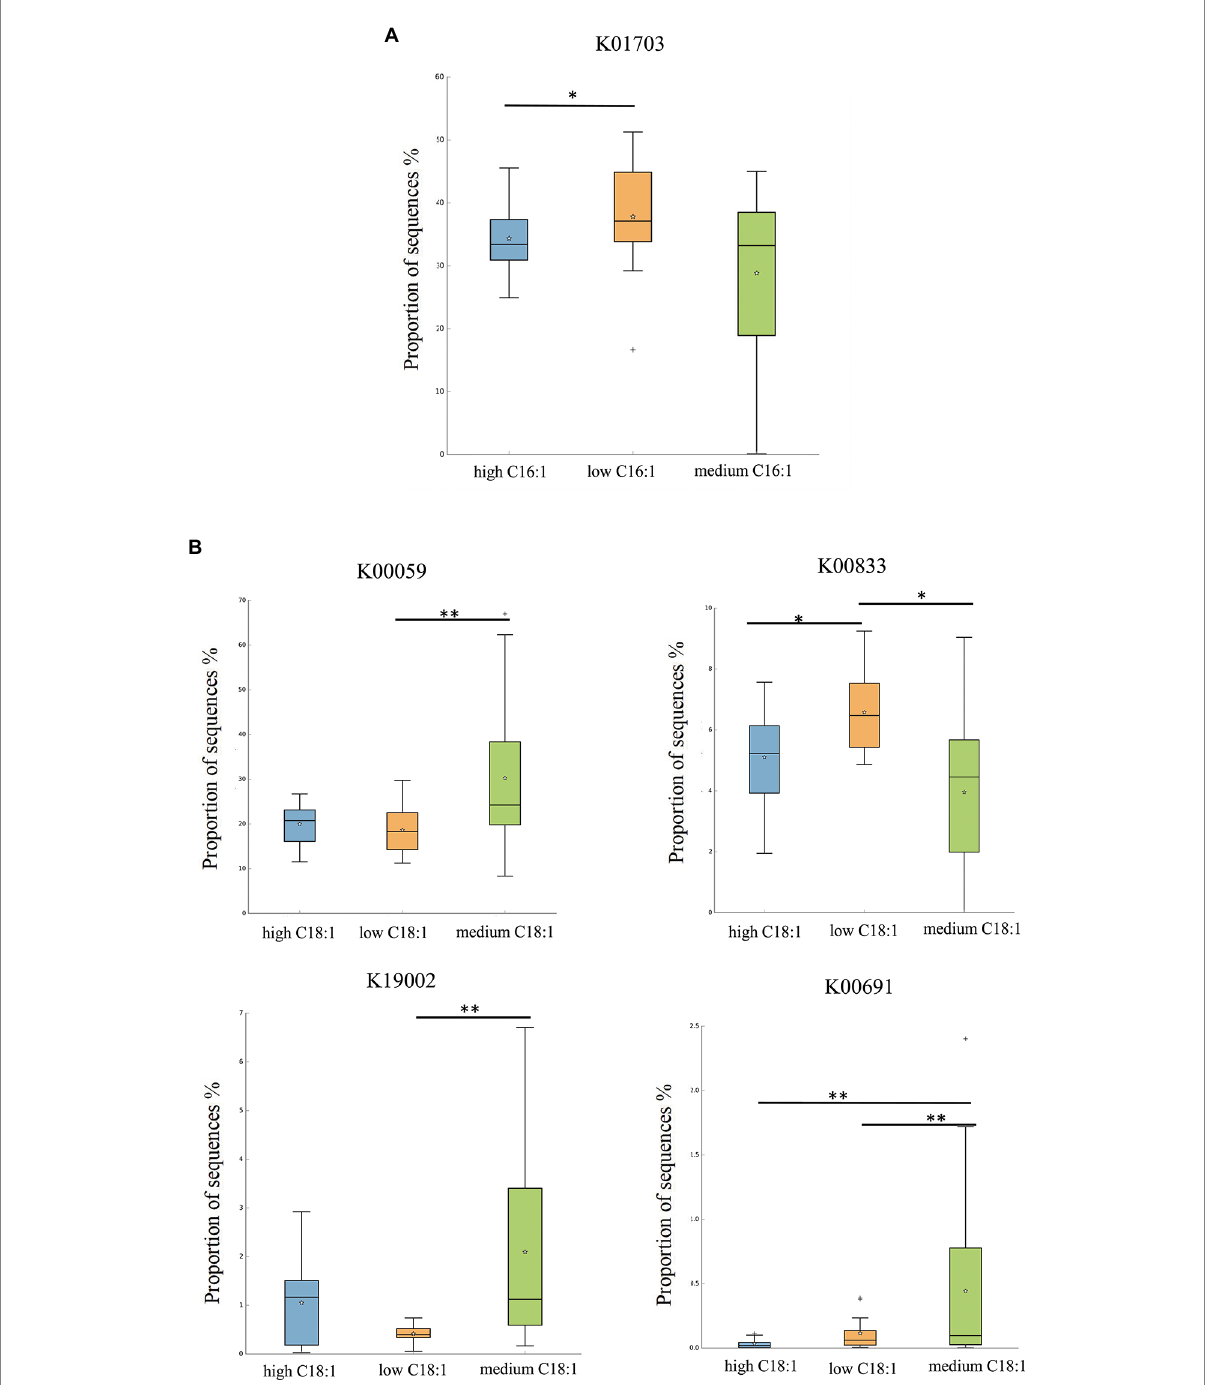
FIGURE 4 KO analysis of significant differences for certain breast milk long-chain FAs. (A,B) represent the KO analysis of breast milk C16:1, and C18:1, respectively, of different content groups, and the results are shown in the box diagram (orange, green, and blue indicate low, medium, and high content, respectively). * indicates p < 0.05, ** indicates p <